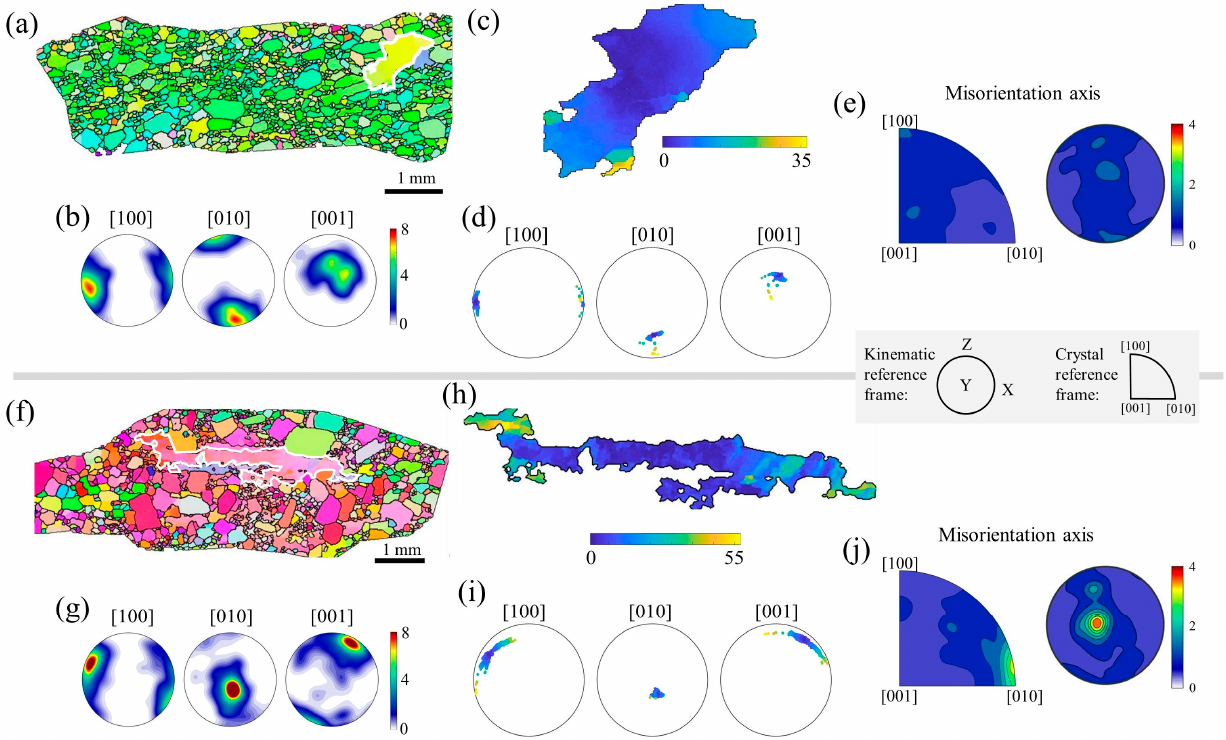
Figure 7. Analysis of two olivine porphyroclasts with high intragrain misorientation, showing consistent intragrain misorientation and bulk CPO characteristic of A-type fabric ( a – e ) and E-type fabric ( f – j ). ( a , f ) Sections of the orientation map (highlighted in red in Figure 4). ( b , g ) Crystallographic preferred orientation (CPO) of olivine (area-weighted) for the area in ( a , f ), respectively. ( c , h ) Intragrain misorientation in the porphyroclast grain (highlighted in white in maps ( a , f )). ( d , i ) Orientation of the individual porphyroclast where the spread is a trace of the intragrain misorientation. ( e , j ) Misorientation axis plotted on the crystal (left side), and kinematics (right side) reference frames for the misorientation of the porphyroclast grain. The upper section ( a – e ) is characterized by (010)[100] slip system (consistent with A-type fabric), and the lower section is characterized by (001)[100] slip system (consistent with E-type